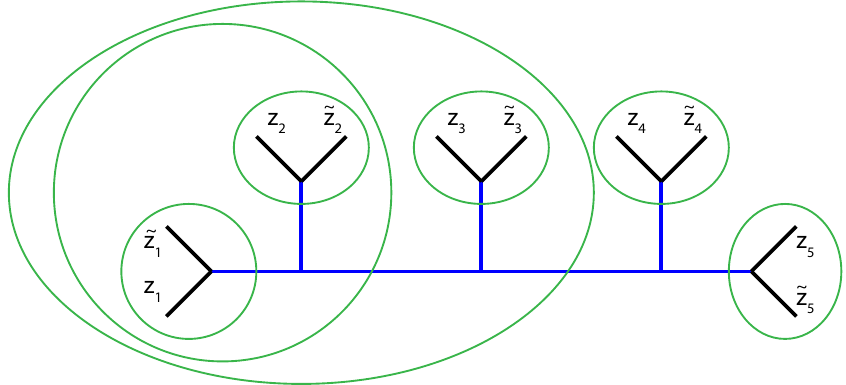
. The blue lines correspond to (cid:22) z i